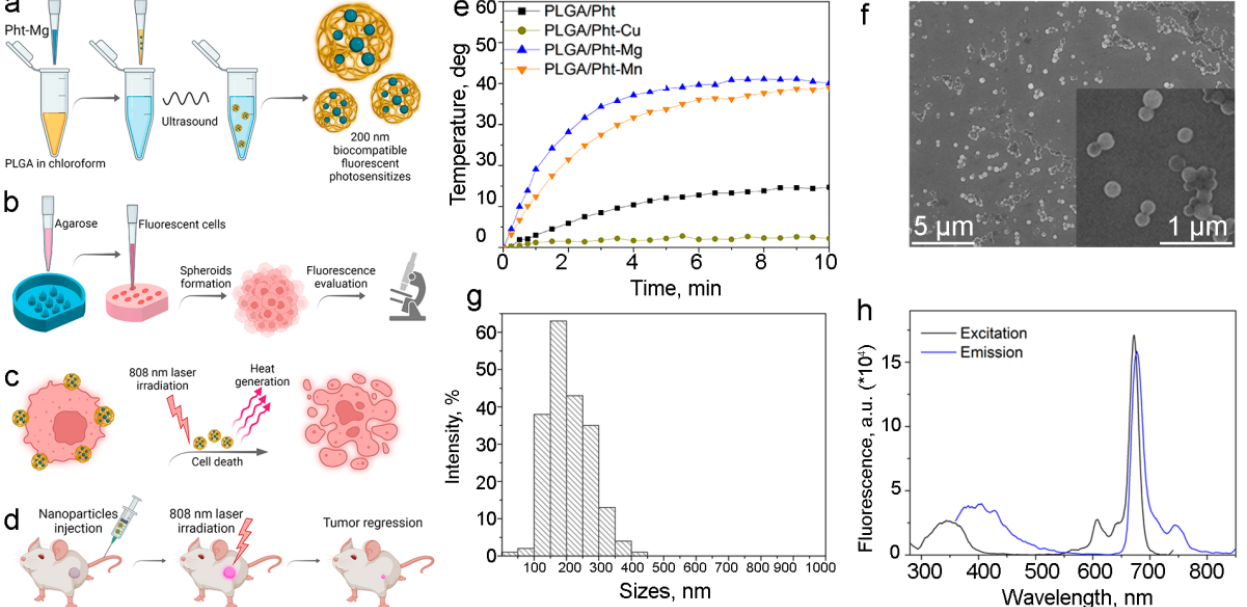
Figure 1. Synthesis and characterization of PLGA-based nanocarriers for photothermal therapy. ( a ) Scheme of nanopar- ticle synthesis. The mixture of PLGA and Pht-Mg in chloroform is poured into the PVA with chitosan oligosaccharide lactate solution in water and subjected to intensive sonication. ( b ) 3D spheroids formation in agarose gel. Agarose solu- tion was added to the plastic molds and was allowed to solidify at room temperature. Next, a suspension of cells is added to the agarose microwells in order to obtain spheroids on 3–6 days of cultivation. The fluorescence of obtained 3D cell culture is further evaluated using epifluorescent microscopy. ( c ) As obtained 3D spheroids were incubated with PLGA/Pht-Mg nanoparticles followed by 808 nm laser irradiation that leads to the heating of nanoparticles and cell death. ( d ) As-synthesized nanoparticles were used for imaging and treatment of orthotopic tumors in vivo. ( e ) Photothermal properties of PLGA, PLGA/Pht-Mg, PLGA/Pht-Mn, and PLGA/Pht-Cu nanoparticles under the 808 nm light irradiation. ( f ) Scanning electron microscopy images of PLGA nanoparticles. ( g ) Size distribution of PLGA/Pht-Mg nanoparticles, mean size is 208 ± 66 nm. ( h ) Fluorescence excitation and emission spectra of PLGA/Pht-Mg nanoparticles.